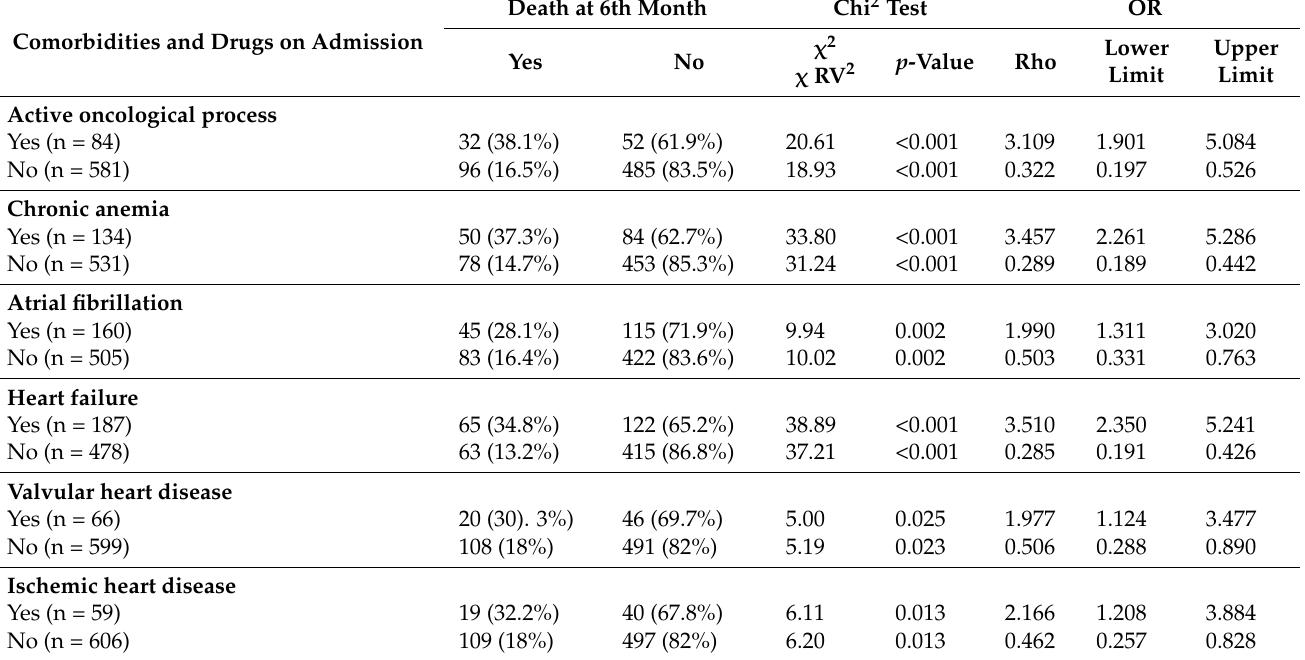
Table 2. Results of the Chi 2 test between mortality at the sixth month and comorbidities and drugs at